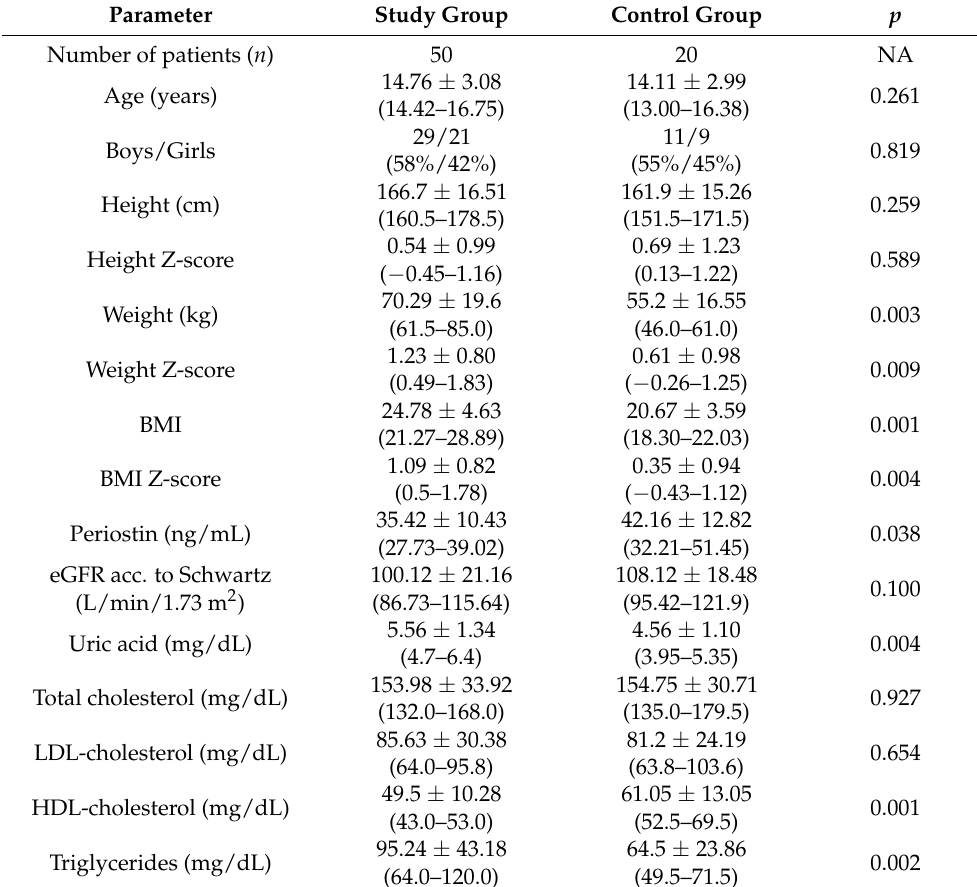
Table 1. Clinical and biochemical parameters of the study and the control group (data presented as numbers or mean ± standard deviation and interquartile